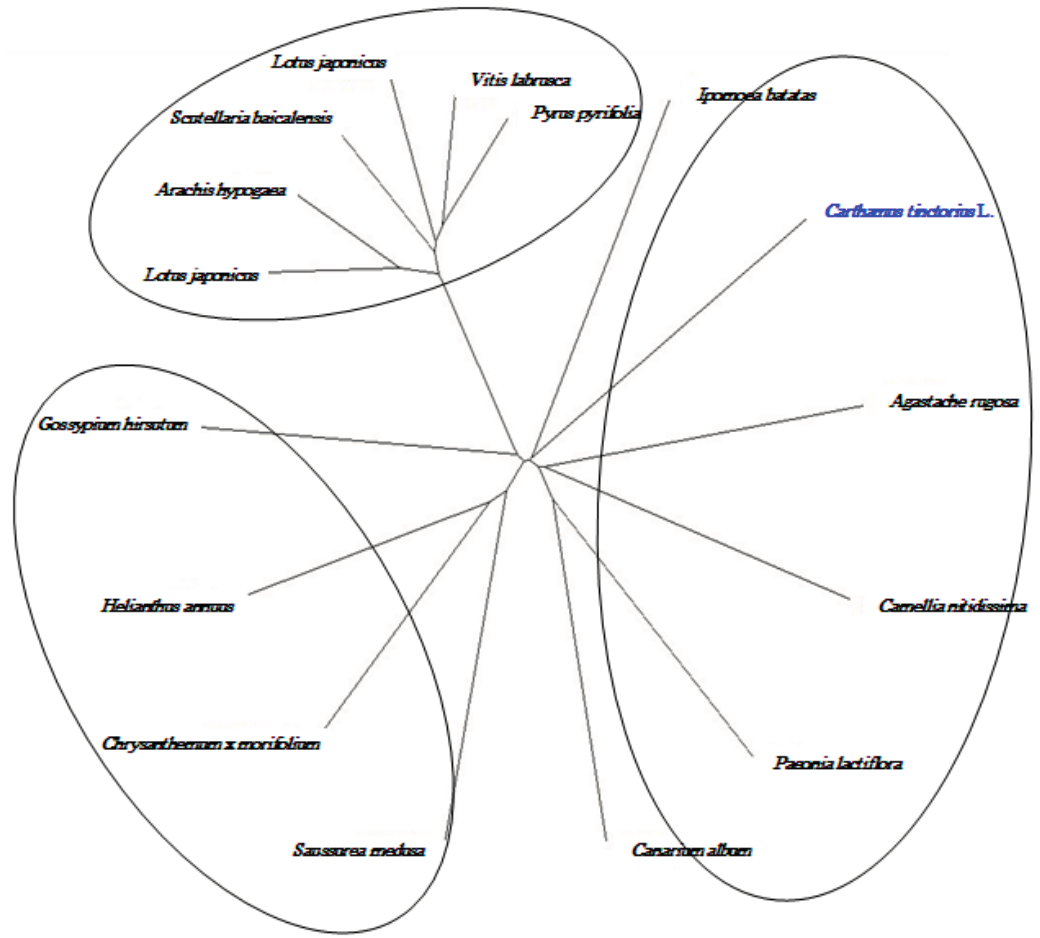
Figure 11. The amino acid sequence of chalcone isomerase ( CHI ) gene of safflower. It encoded 217 amino acids containing 654 bases.